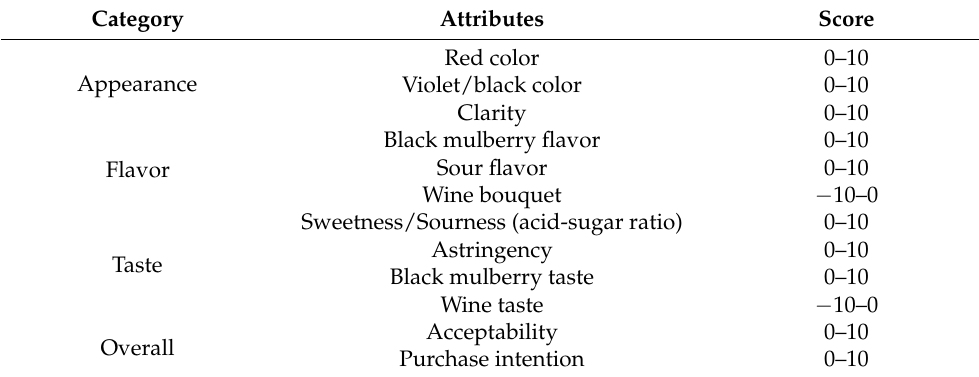
Table 3. Sensory attributes for fermented black mulberry